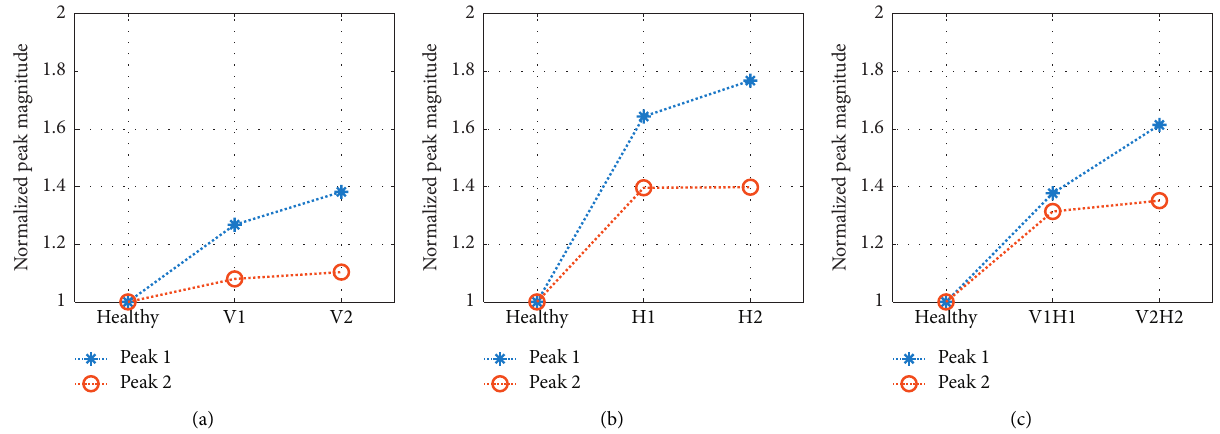
Figure 23: Shifts in peak magnitudes caused by PZT breakage defects. (a) Cases: V1, V2. (b) Cases: H1, H2. (c) Cases: V1H1, V2H2.